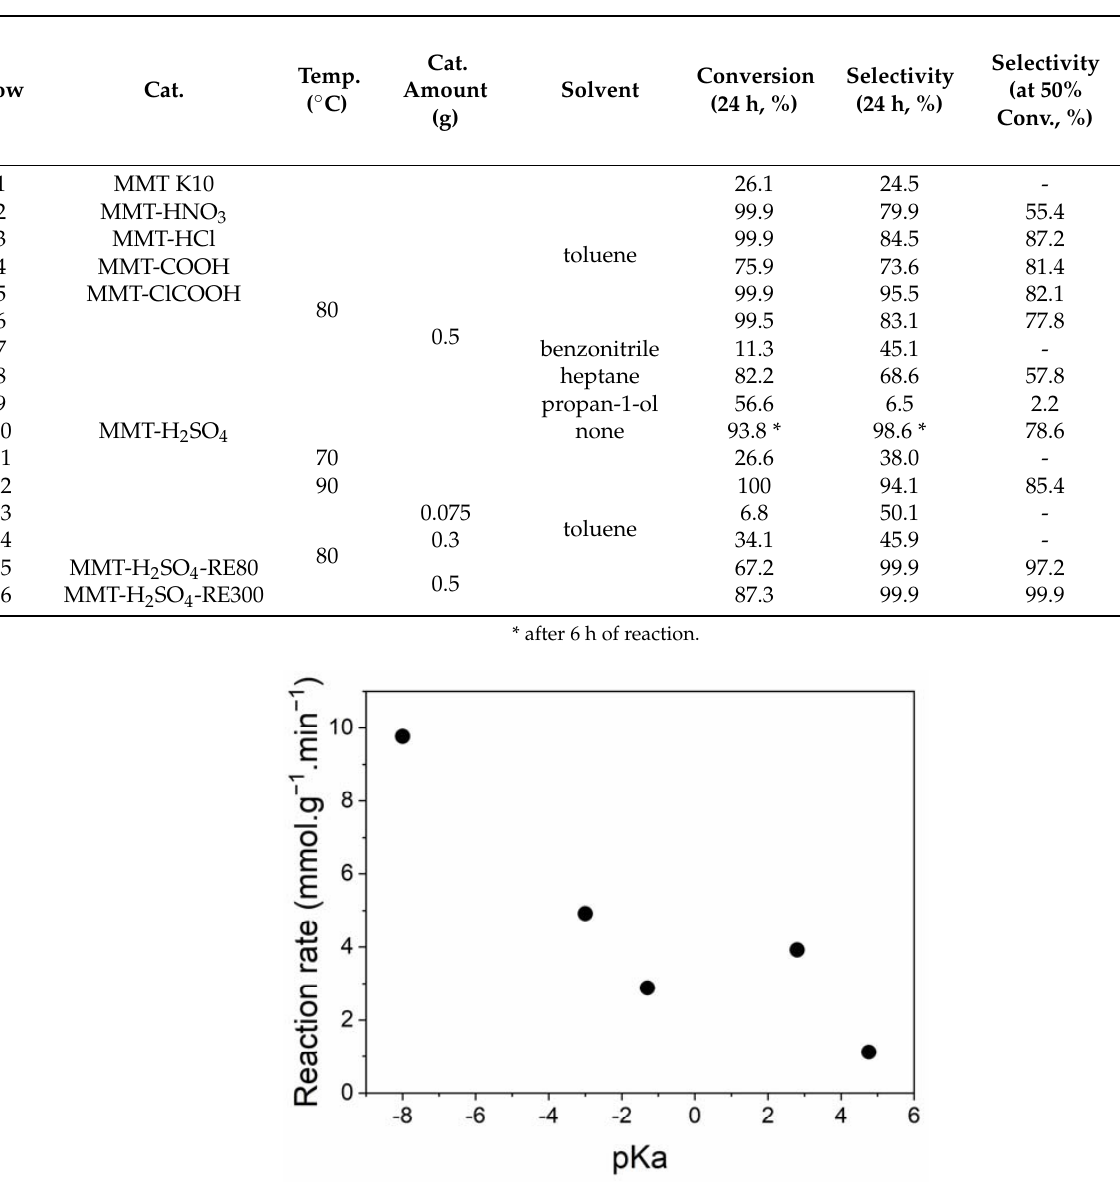
Table 6. Reaction result using different reaction conditions (solvent 3 mL, carvone 6 mmol, 24 h), selectivity to carvacrol.